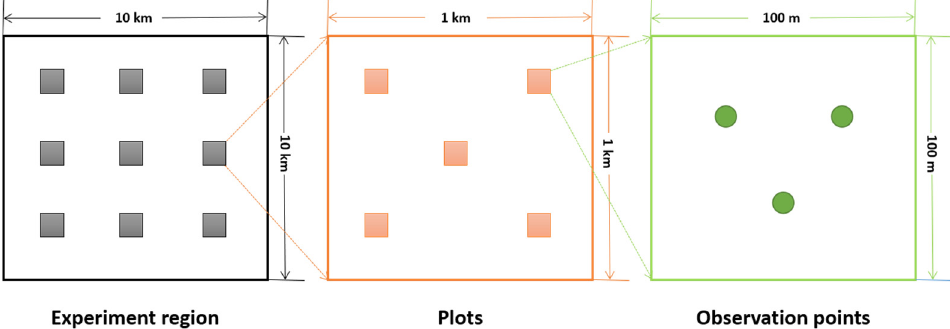
Figure 2. Field sampling design for soil moisture station.